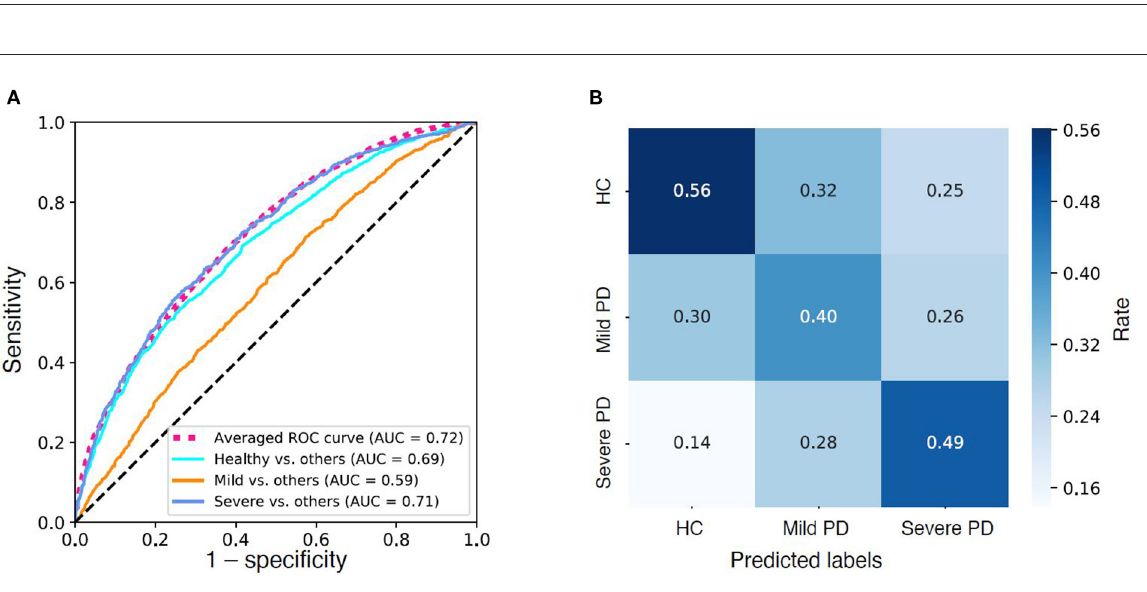
FIGURE2 Model performance. (A) Receiver operator characteristic (ROC) curves of the three “one- vs. -rest” base predictive models and the average ROC curve of the combined multi-label predictive model. (B) Confusion Matrix of the predictive model. Color density indicates